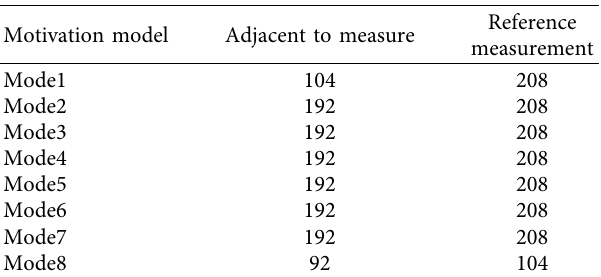
Figure 13: Schematic diagram of the excitation and measurement model: (a) adjacent excitation adjacent measurement; (b) interval excitation reference Table 3: The amount of measurement data for each excitation and measurement mode.